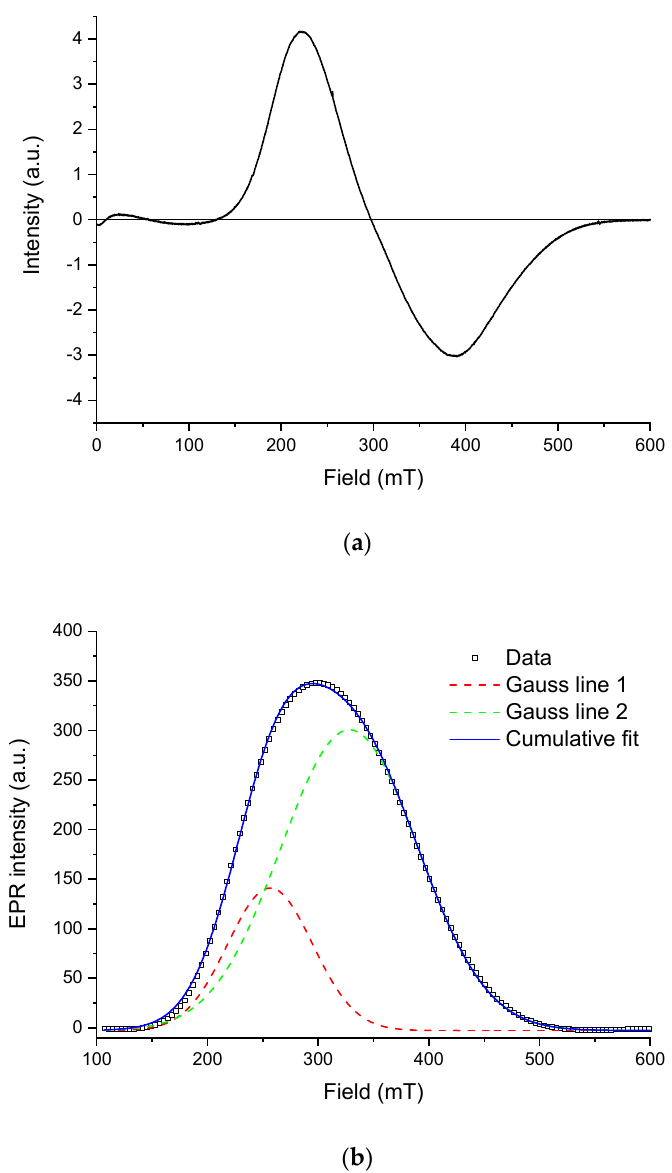
Figure 9. Electron paramagnetic resonance (EPR) spectroscopy of the isolated magnetosomes: ( a ) EPR spectrum measured at room temperature; ( b ) decomposition of the first derivative (solid line) of the EPR signal (absorption spectrum) into two Gaussian components (colored dashed lines). Bold line shows the cumulative fit.